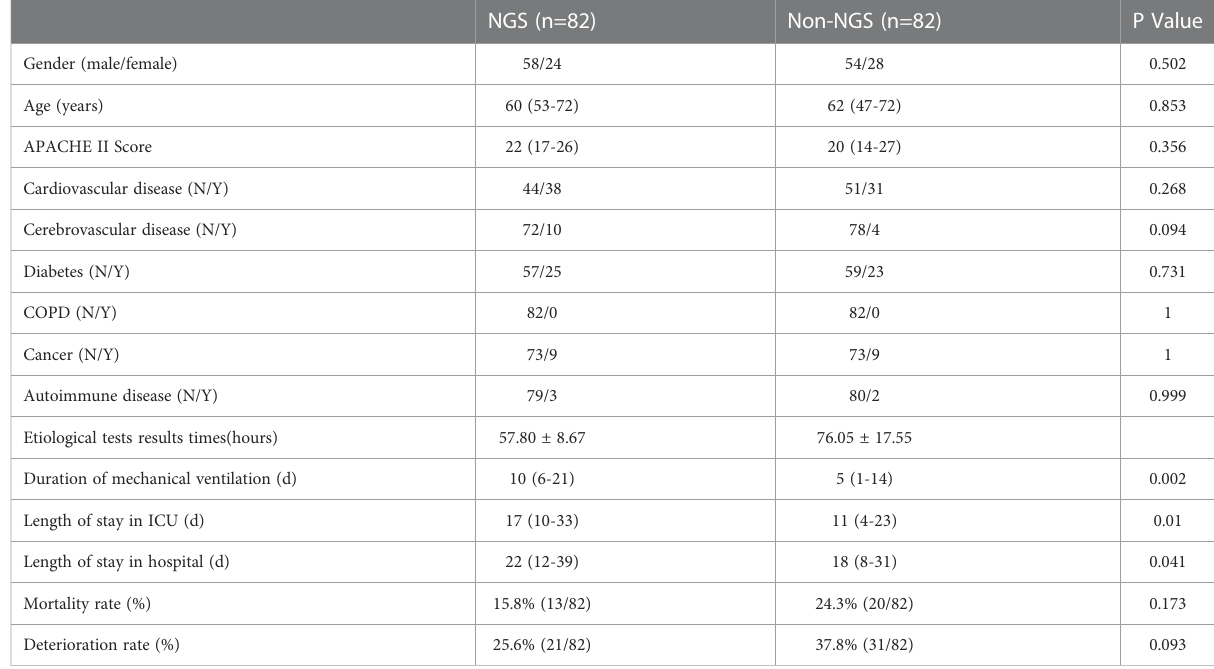
TABLE 4 Characteristics and clinical indices of NGS and non-NGS groups after propensity matching.